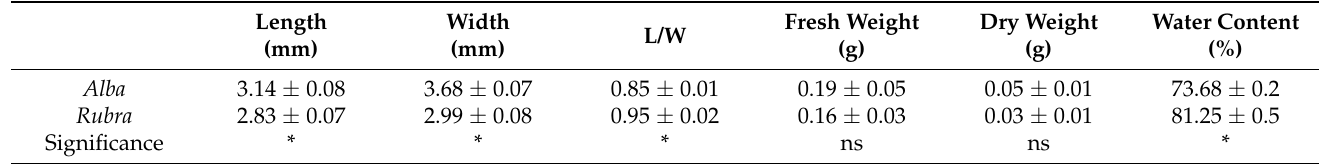
Table 1. Petal length, width, length/width ratio, fresh and dry weight, and water content of Rosa rugosa cv. Alba (white color) and cv. Rubra (purple color) flowers.